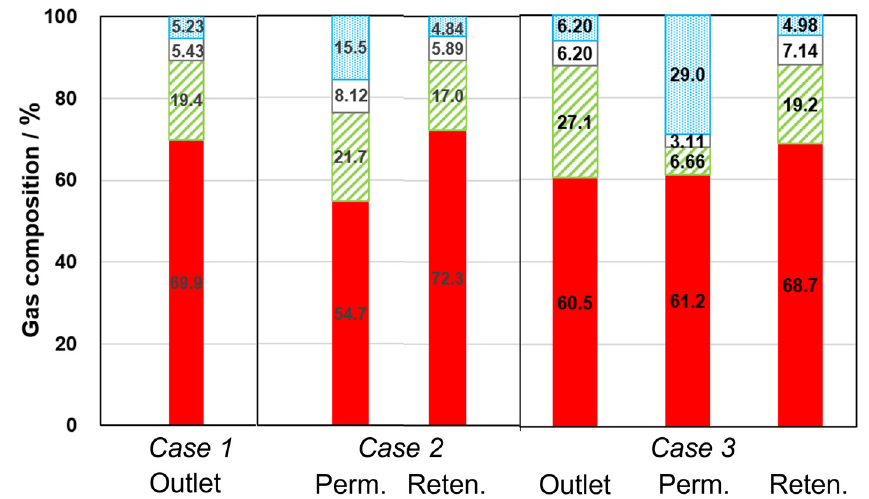
Figure 7. Exit gas compositions of each reactor at 560 K. The bars from bottom to top showed H 2 , CO 2 , CO and H 2 O.